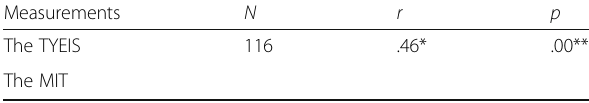
Table 3 Results of correlation between the TYEIS and the